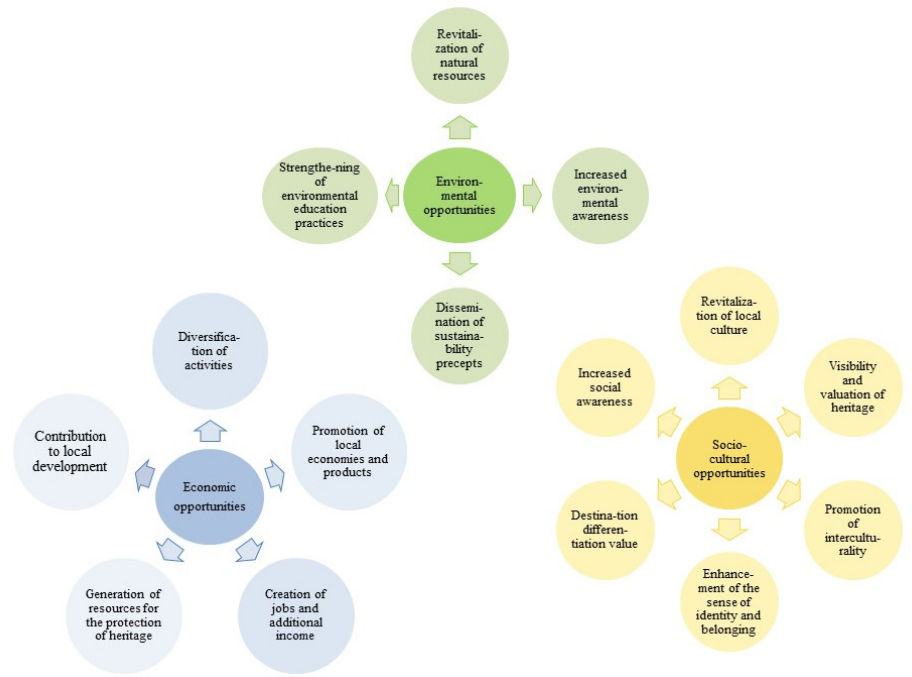
Figure 1. Tourism-related opportunities.